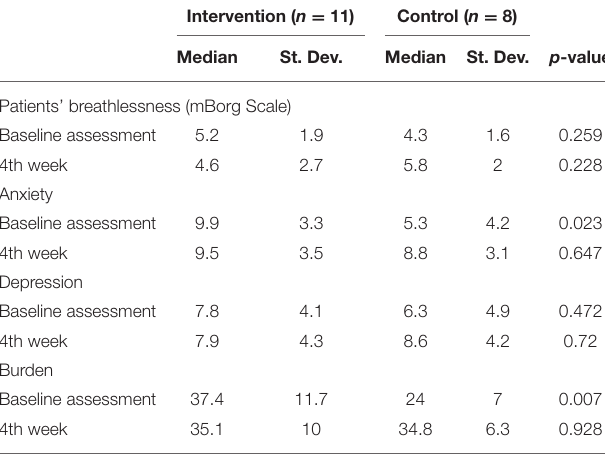
TABLE 7 | Family caregivers’ measurements at baseline assessment and final